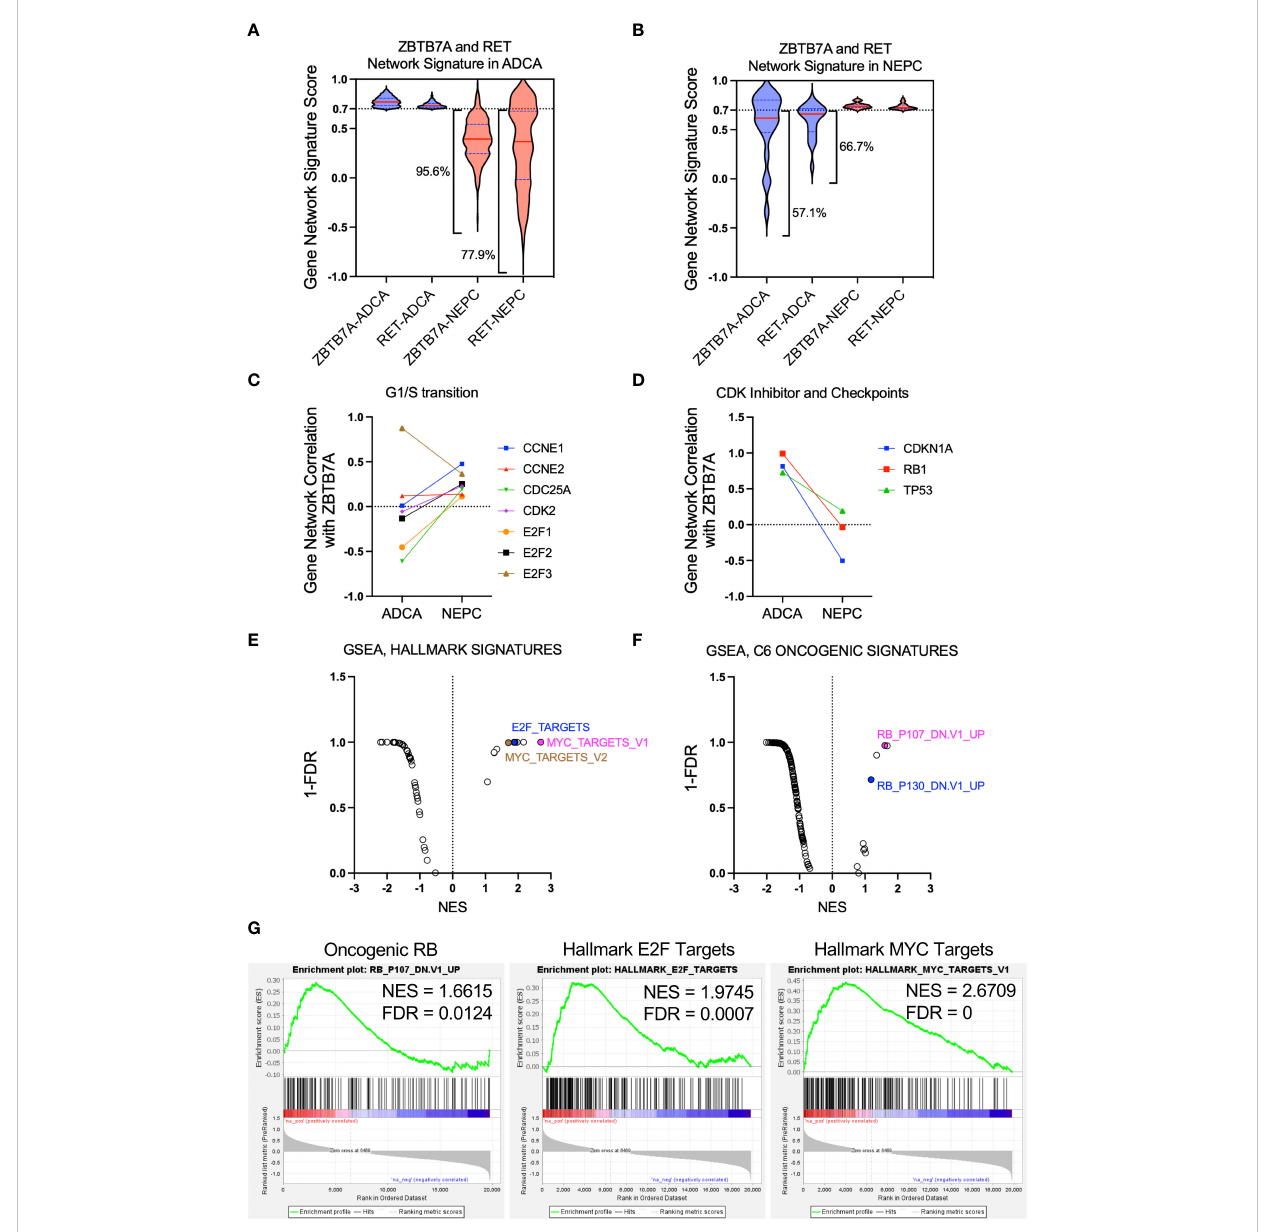
FIGURE 2 Gene network correlation analysis revealed distinct gene network associations with ZBTB7A in NEPC versus prostate adenocarcinoma. (A, B) Gene network signature from both ZBTB7A and RET in ADCA (A) or NEPC (B) was assessed in the other state and depicted using violin plots (see Methods). Gene network signature in each CRPC state was generated from the gene networks with correlation coef fi cients above 0.7 for both ZBTB7A and RET . The broad violin plots indicate the dissimilarity of correlation coef fi cients for a gene network signature. The percentages of gene network signatures below 0.7 are indicated on the plots. (C) Gene network correlation of genes related to G1/S transition with ZBTB7A in ADCA and NEPC. (D) Gene network correlation of CDK negative regulator ( CDKN1A ) and checkpoint ( RB1 , TP53 ) genes with ZBTB7A in ADCA and NEPC. (E, F) GSEA analysis of ZBTB7A gene pro fi les based on NEPC and ADCA tumors from Beltran et al., 2016 (see Methods). Each dot represents a gene signature. Among the signatures enriched in ZBTB7A gene pro fi le of NEPC, the cell cycle progression related ones are labeled. For the full list of signatures, see Supplementary Table 4 (G) Individual enrichment pro fi les are